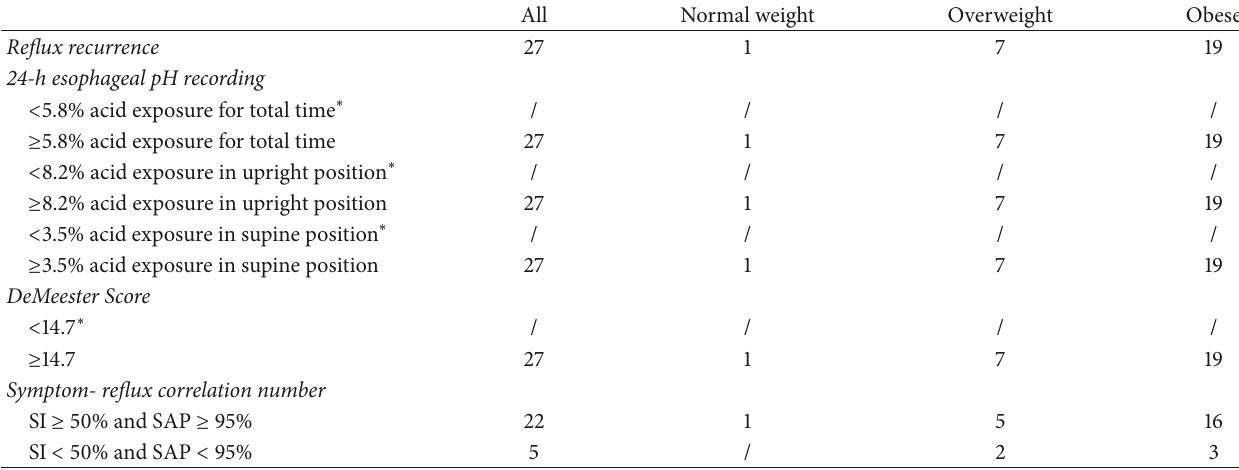
Table 5: Reflux recurrence and esophageal 24-hour pH-impedance monitoring.